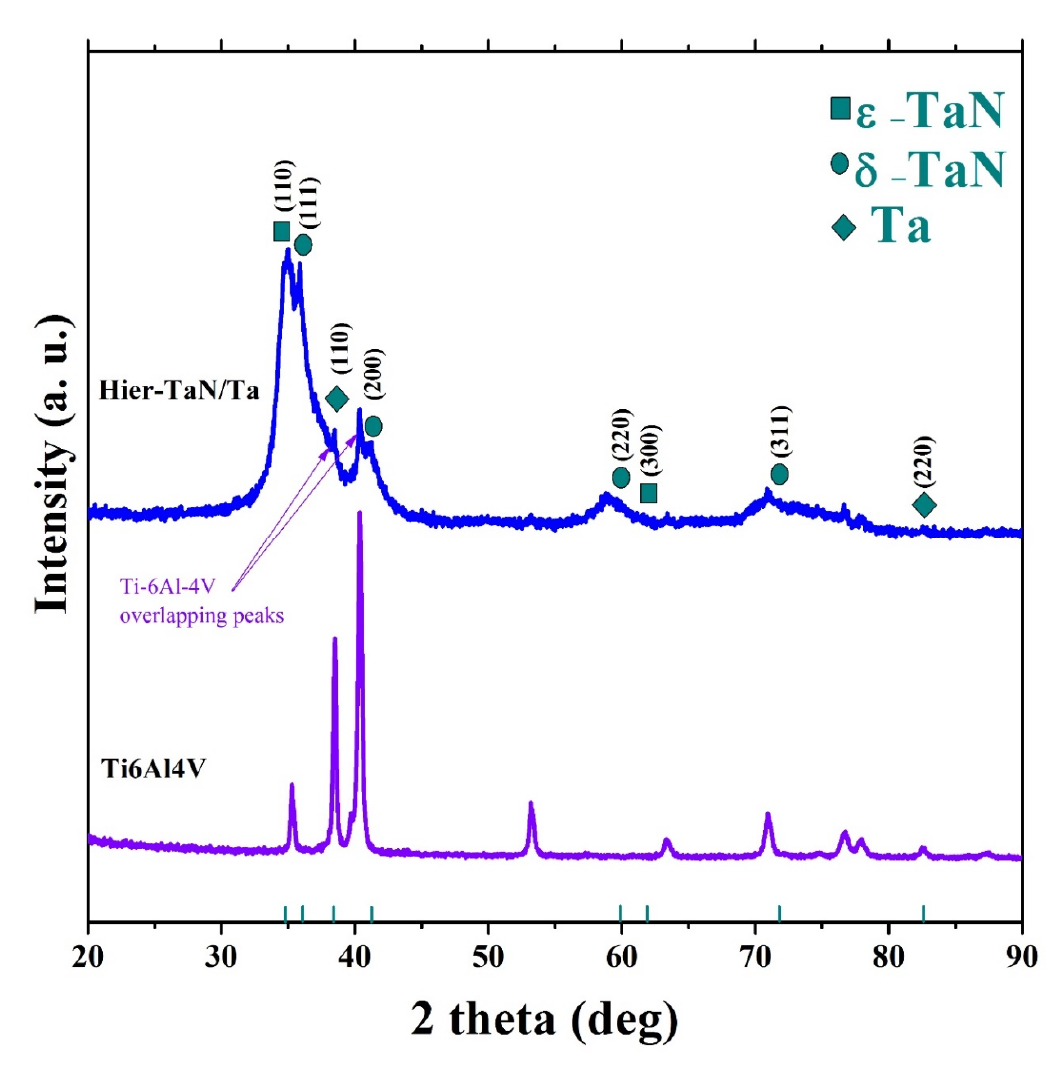
Figure 3. XRD patterns of the Hier-TaN-Ta coating and Ti6Al4V substrate.